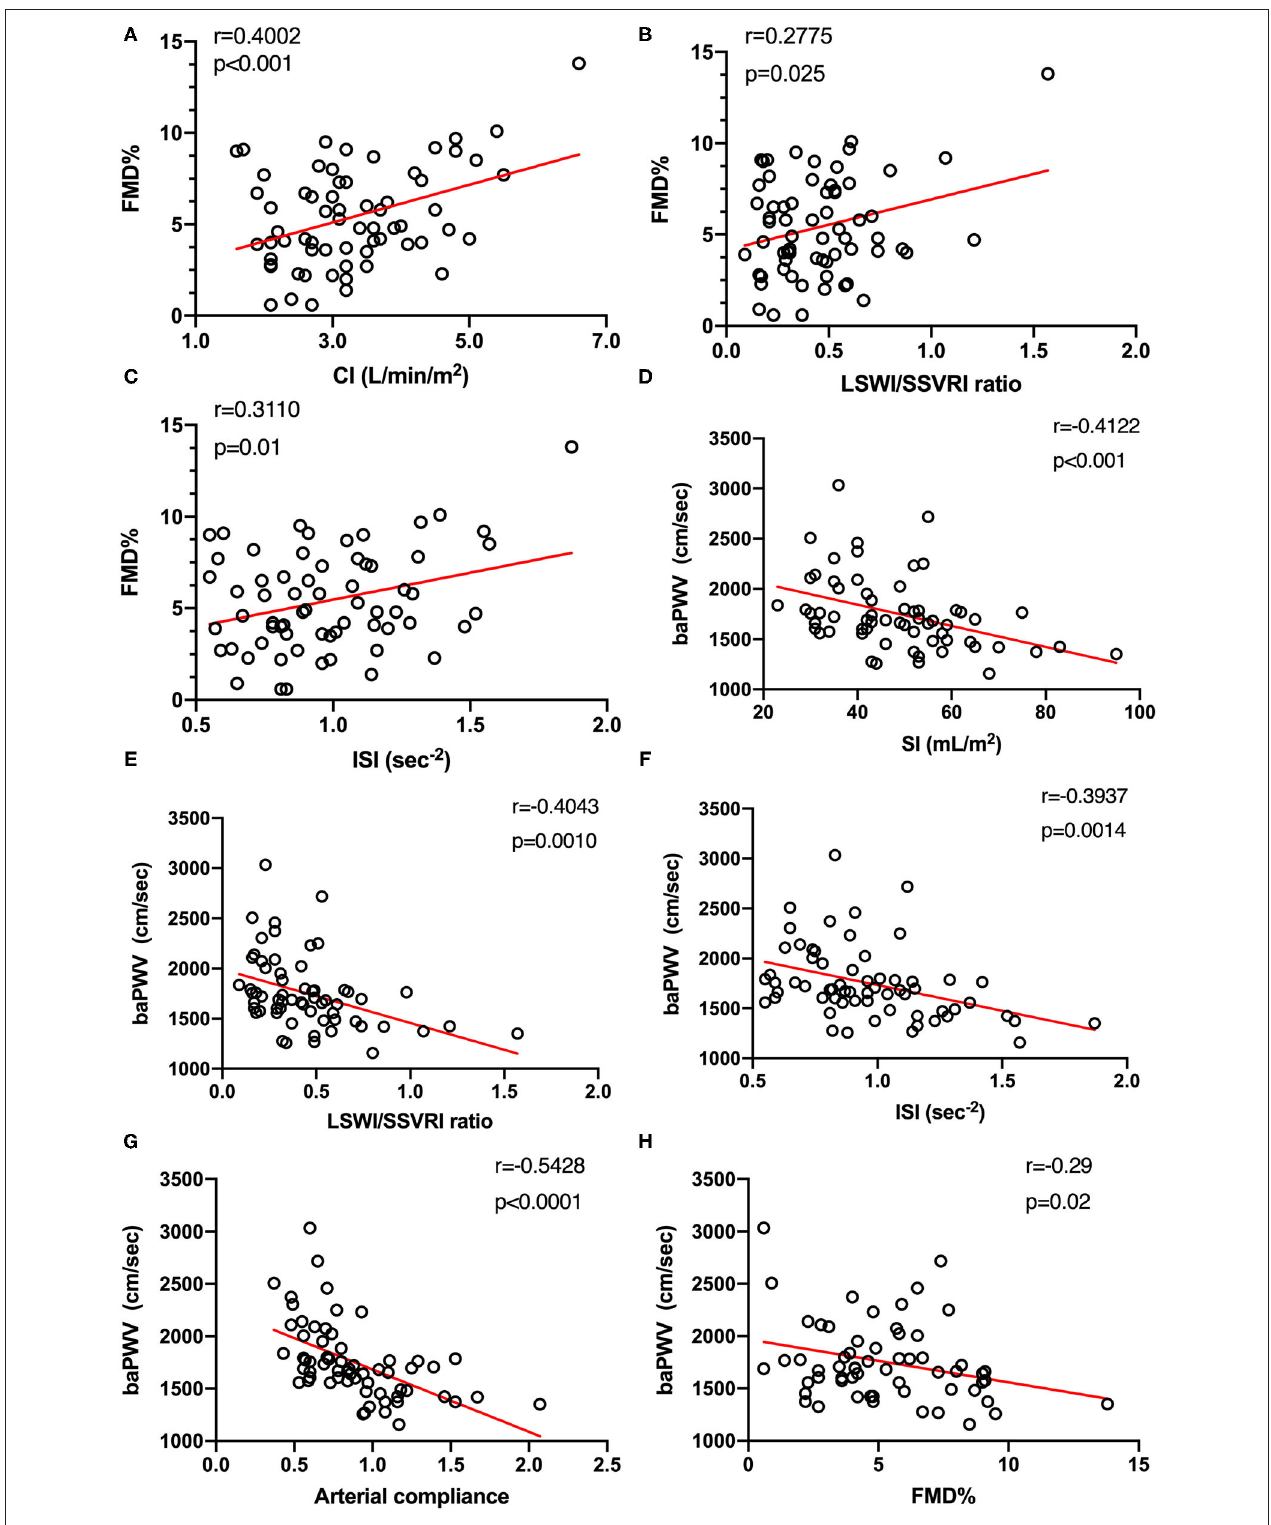
FIGURE 2 | Hemodynamic states are associated with macrovascular endothelial function ( n = 65) and arterial stiffness ( n = 63). (A–C) Relationship between systemic hemodynamic parameters and FMD was tested using Pearson’s correlation coefficients. (D–F) Moderate and significant correlations were found between systemic hemodynamic parameters and baPWV. (G) Arterial compliance, defined as stroke index divided by pulse pressure, was also used to evaluate arterial stiffness.